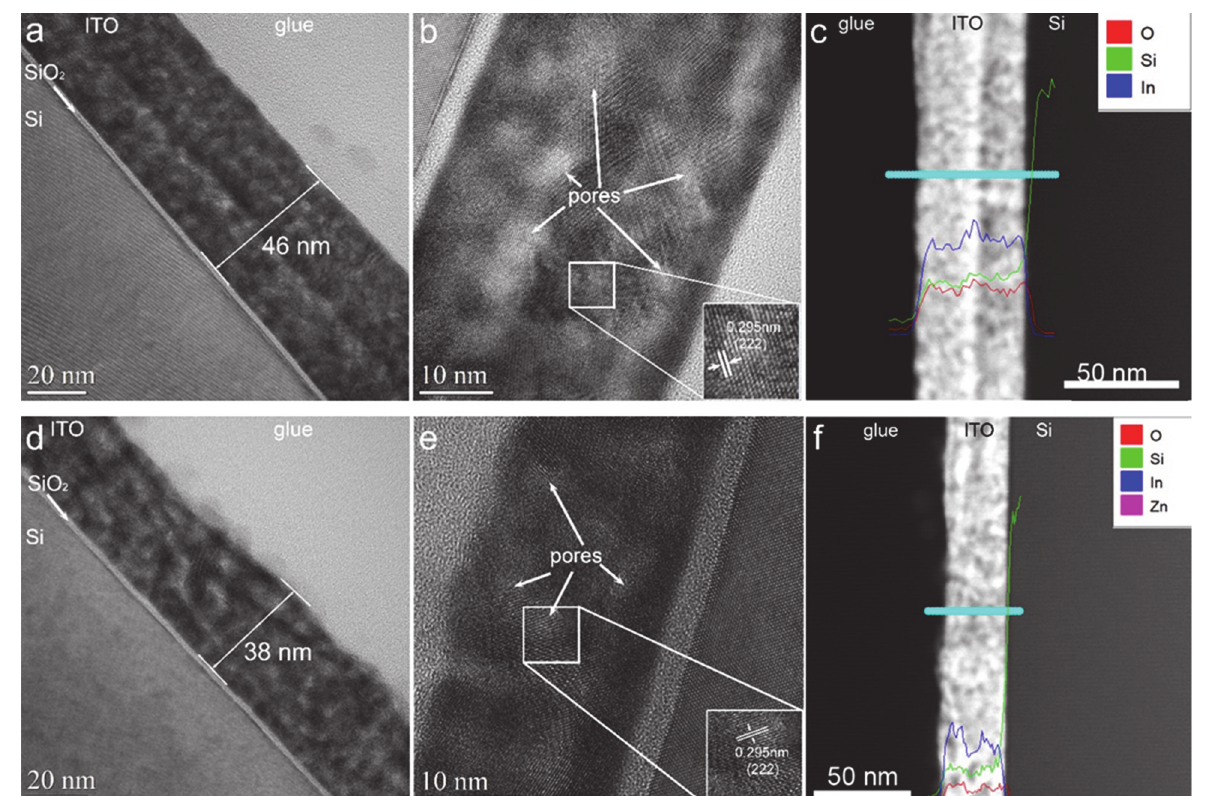
Figure 4. CTEM images ( a , d ), HRTEM images ( b , e ), and EDX line scan in HAADF image ( c , f ) for ITO and ITO:Zn films, respectively. ITO and ITO:Zn films,